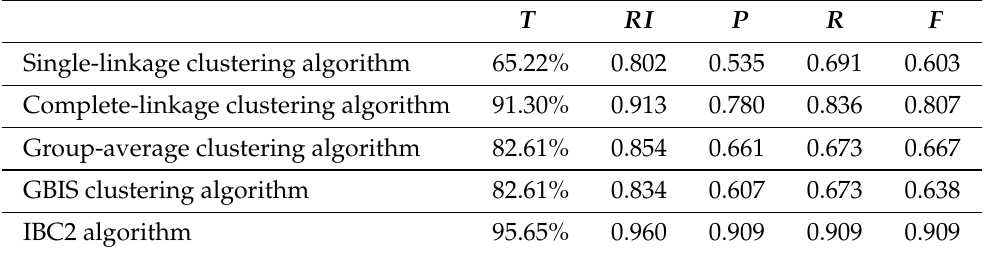
Figure 2. Comparing clustering results, when the number of clusters is given beforehand, using CMU-MMAC database. Table 8. Comparing evaluation parameters using CMU-MMAC